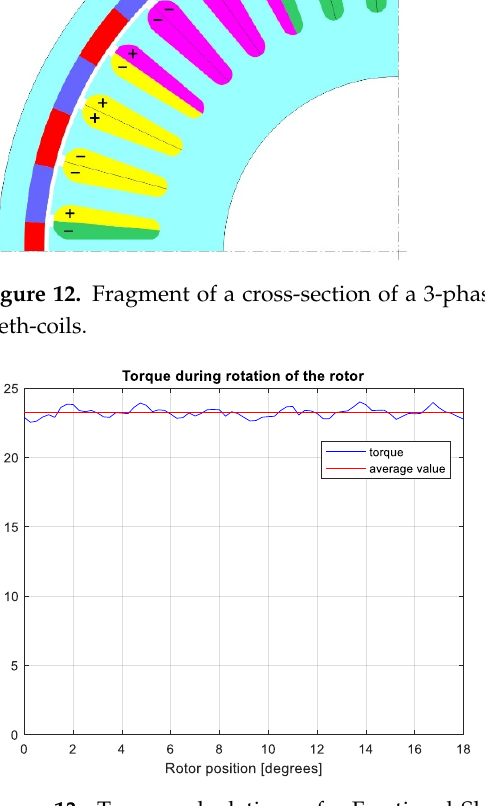
Figure 12. Fragment of a cross-section of a 3-phase FSCW-PMSM machine with 40 poles and 36 teeth-coils.